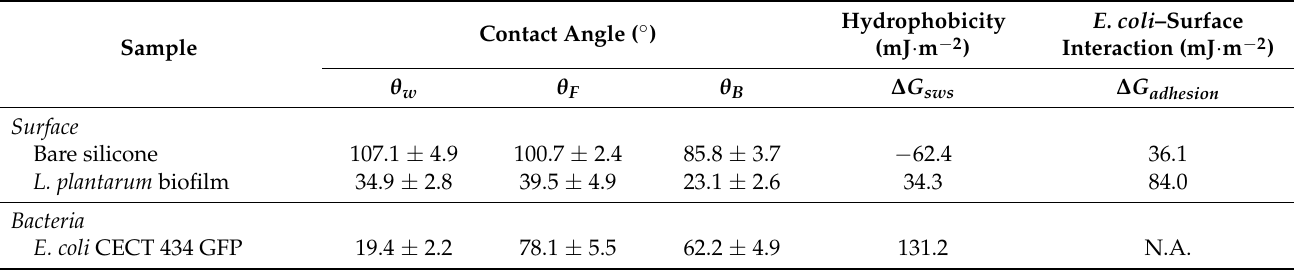
Table 1. Contact angles with the three reference liquids (water, formamide, and α -bromonaphthalene), surface and bacteria hydrophobicity, and energy of E. coli –surface